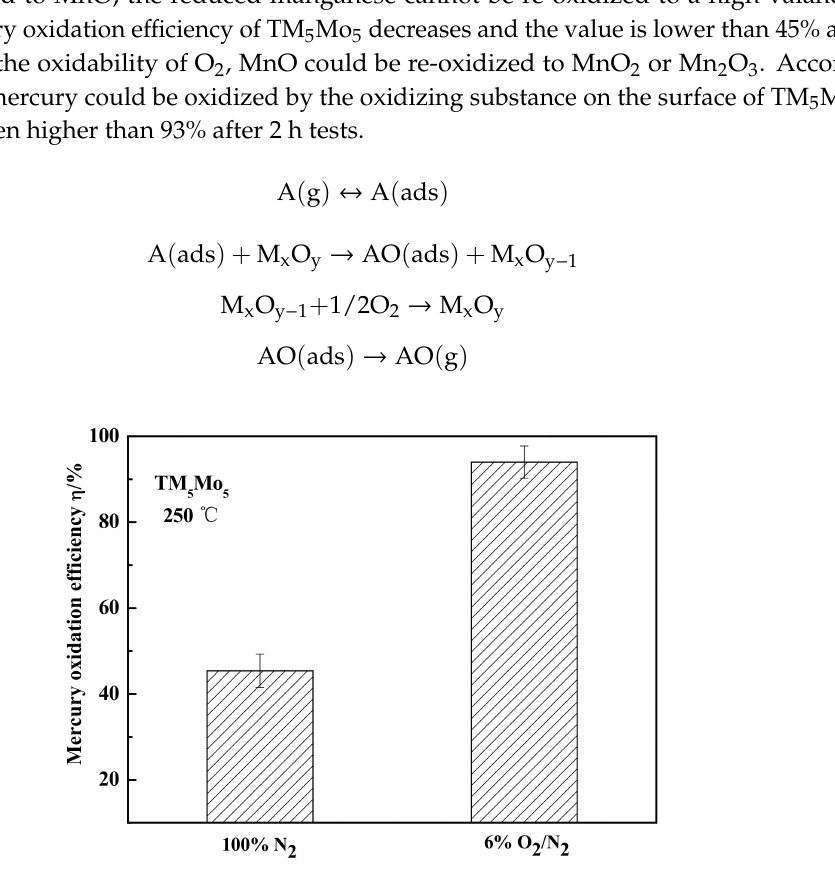
Figure 7. The e ff ect of oxygen on mercury oxidation over TM 5 Mo